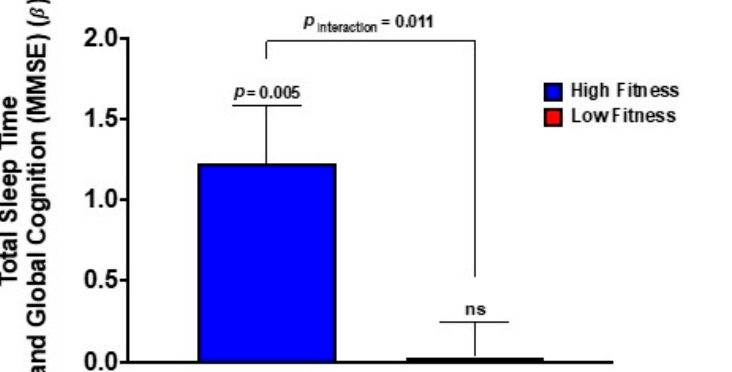
Figure 4. Relations between sleep, fitness, and global cognition in older adults. Cardiorespiratory